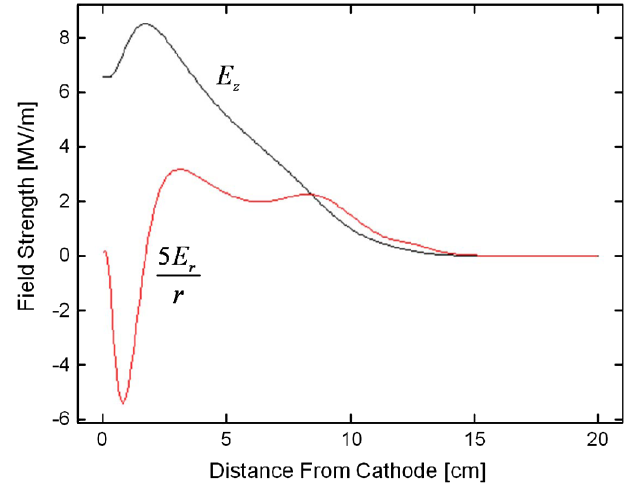
FIG. 6. Simulated longitudinal and radial electric fields along the gun axis, corresponding to a beam with energy 480 keV and launch phase of 40